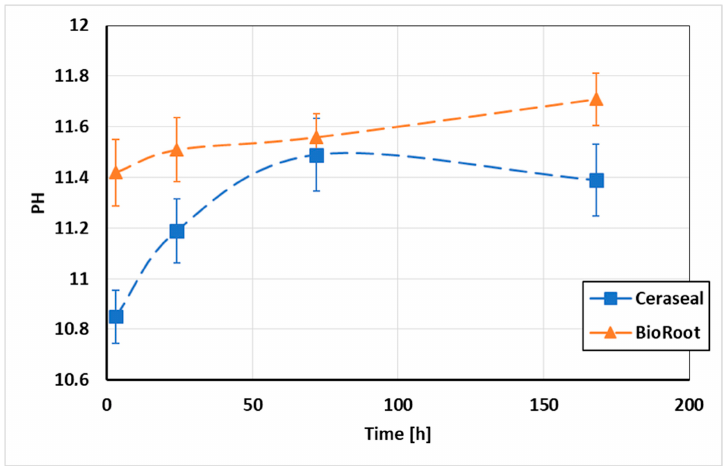
Figure 4. pH changes of water in contact with the sealer materials as a function of time for one